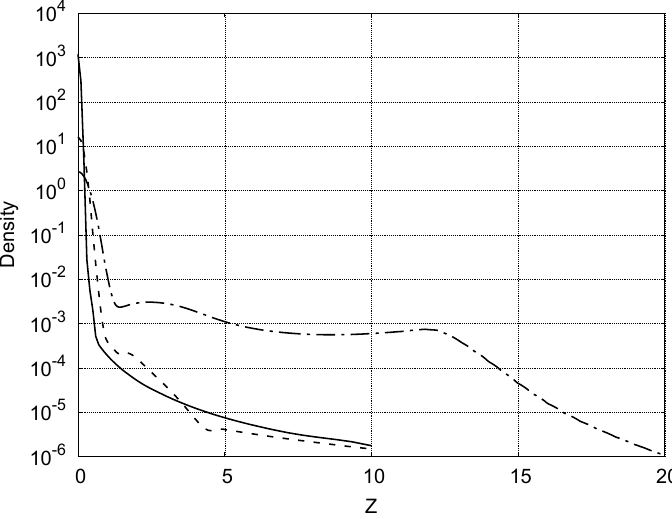
Figure 12. Distribution of density across the disk at distance 2 (solid line), 10 (dashed line) and 20 stellar radius (dashed-dotted line) at ω = 1.01.